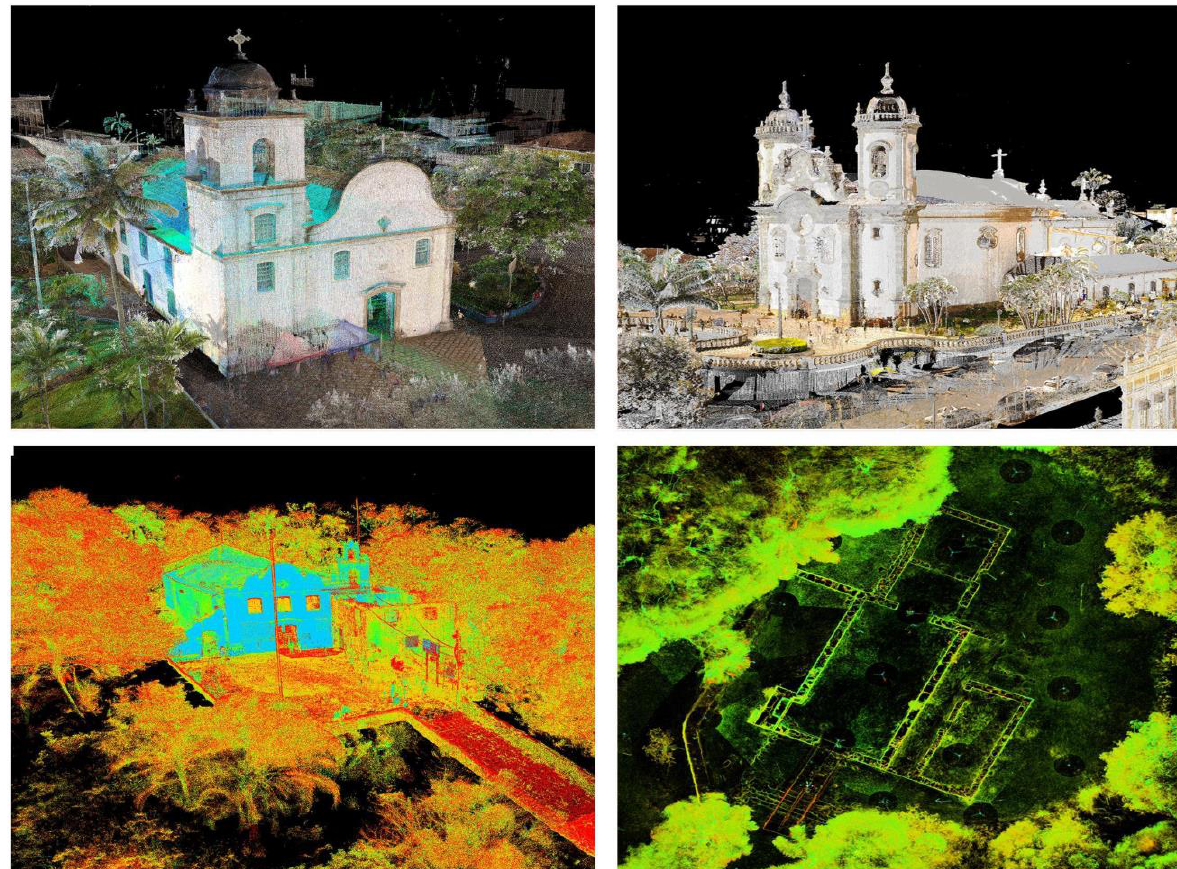
Figure 1. Laser scanner point clouds obtained during the Brasilian experiences (2017-2019): (top-right, clockwise) Igreja Matriz de Sant’Anna, Itanhaem, Church of San Francesco di Assisi in São João del Rei, Convent Nossa Senhora da Conceição, Itanhaem, Ruins of Abarebebe,